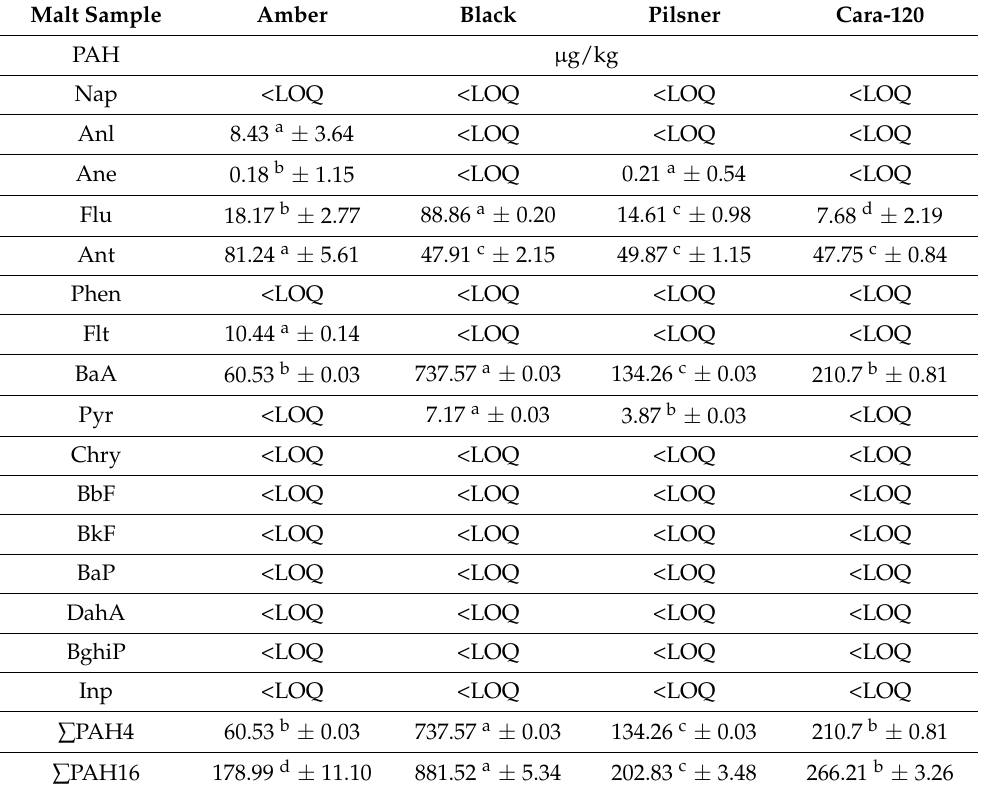
Table 3. Concentrations ( µ g/kg) of PAHs (polycyclic aromatic hydrocarbons) in analyzed malt